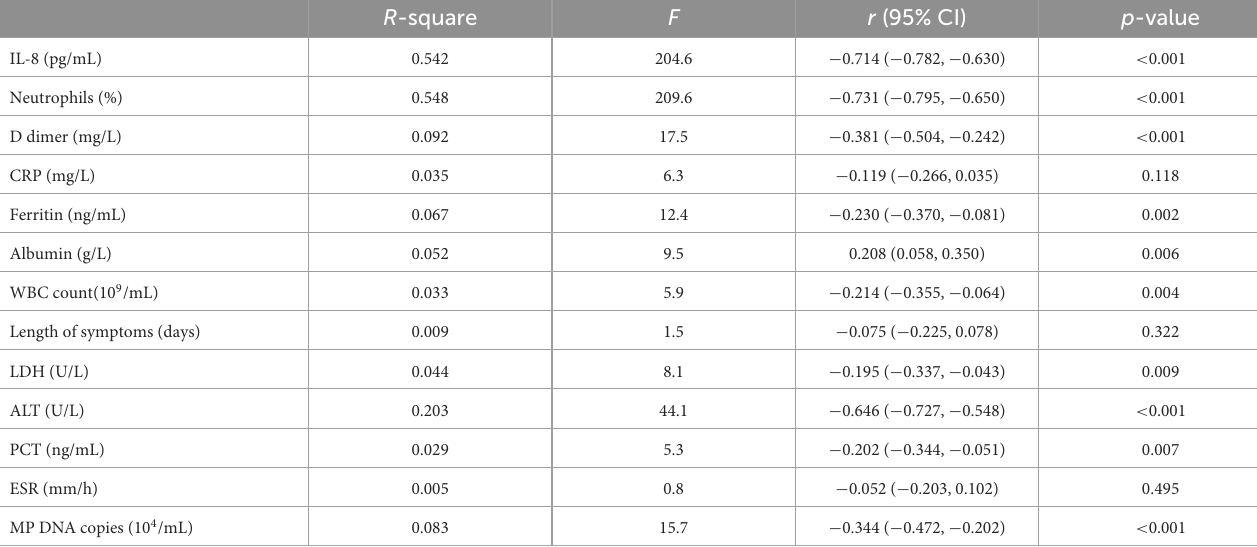
TABLE 2 Associations between serum 25(OH)D and clinical characteristics in children with MPP. R